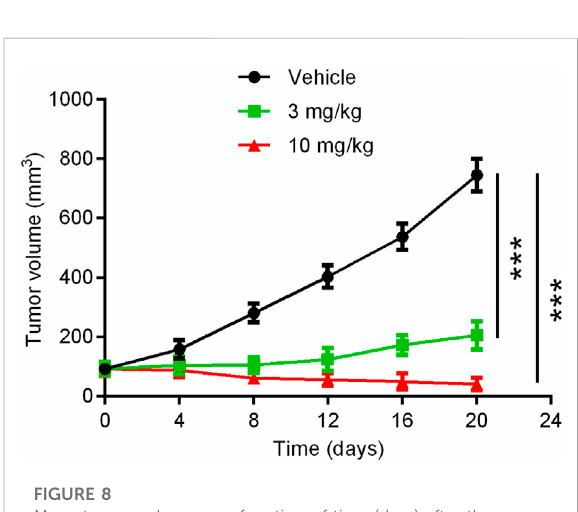
FIGURE 8 Mean tumor volume as a function of time (days) after the treatment of the hit compound 3. Data are represented as mean ± SD, n = 5. *** p <